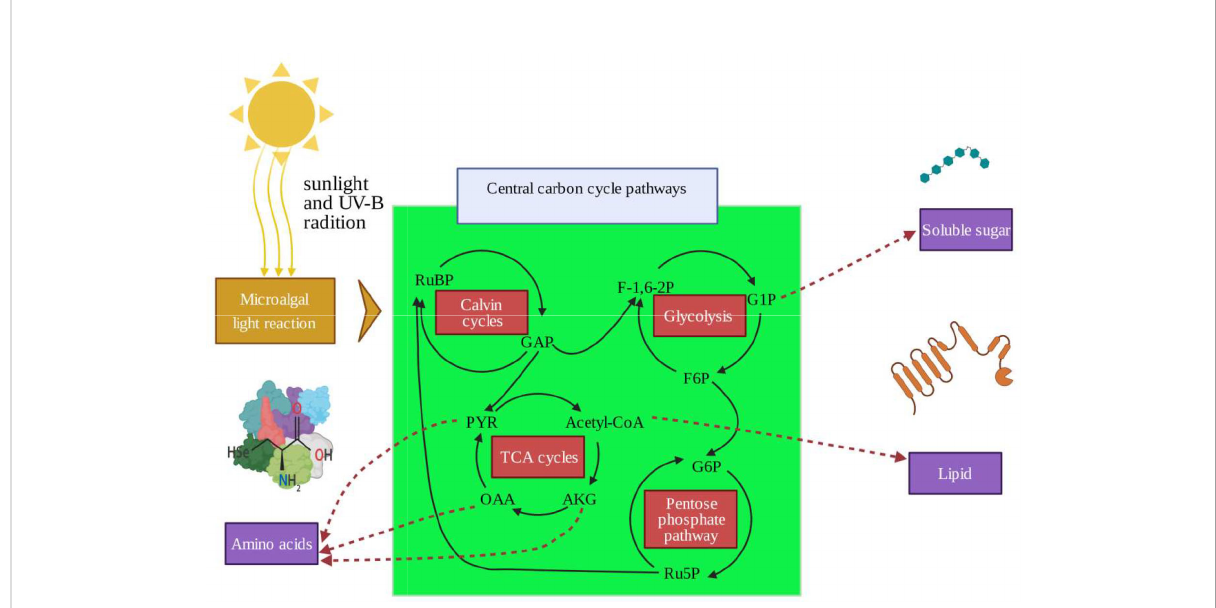
FIGURE 1 Central carbon cycle metabolism and the production of soluble sugar, amino acids, and lipids. RuBP, ribulose-1,5-bisphosphate, GAP, glyceraldehyde-3-phosphate, PYR, pyruvate; AKG, a -ketoglutaric acid; OAA, oxaloacetic acid; F-1;6-2P, fructose 1, 6-bisphosphate; G1P, glucose-1-phosphate; F6P, fructose-6-phosphate; G6P, glucose-6-phosphate; Ru5P, d-xylulose